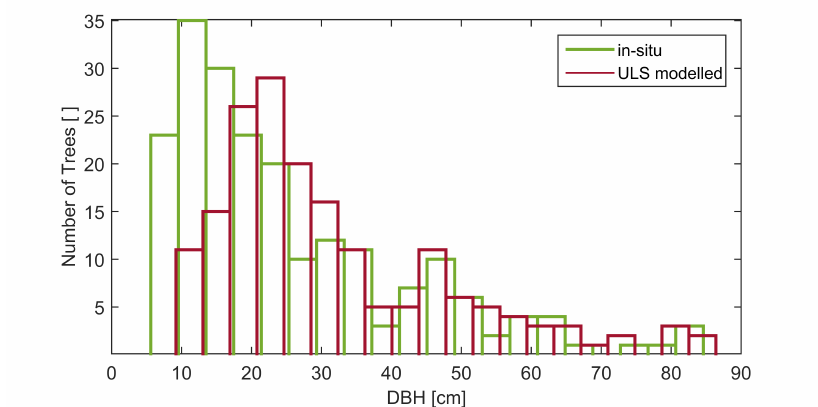
Figure 7. DBH distribution; green: in situ measurements of circular plots; red: ULS DBH distribution within